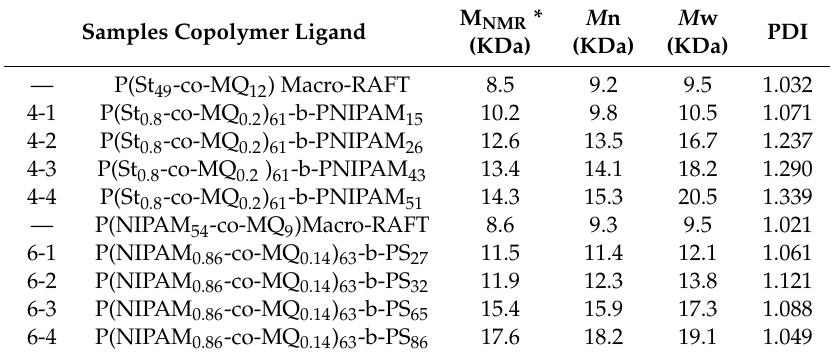
Table 1. Characterization data of copolymers ligand synthesized by the RAFT